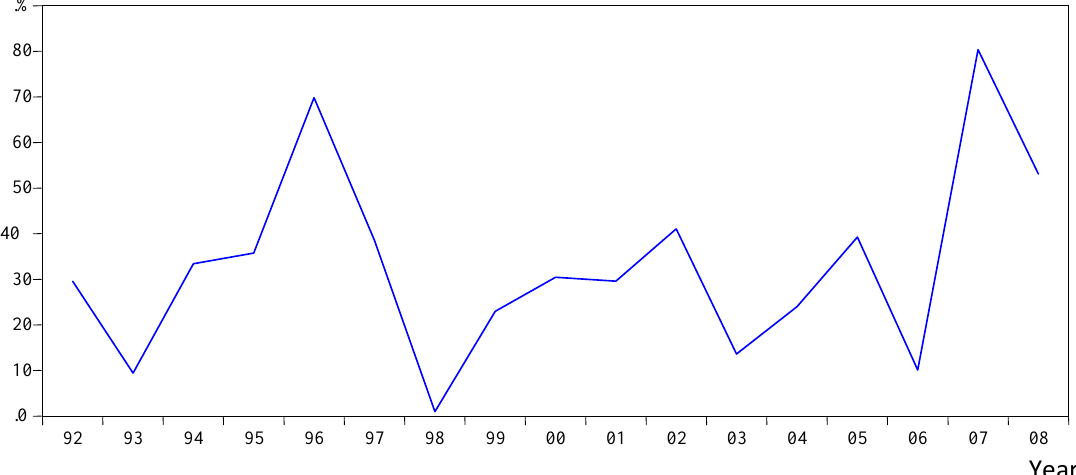
Figure 1 Annual growth rates of private investment in new buildings in urban areas (source: Central bank of